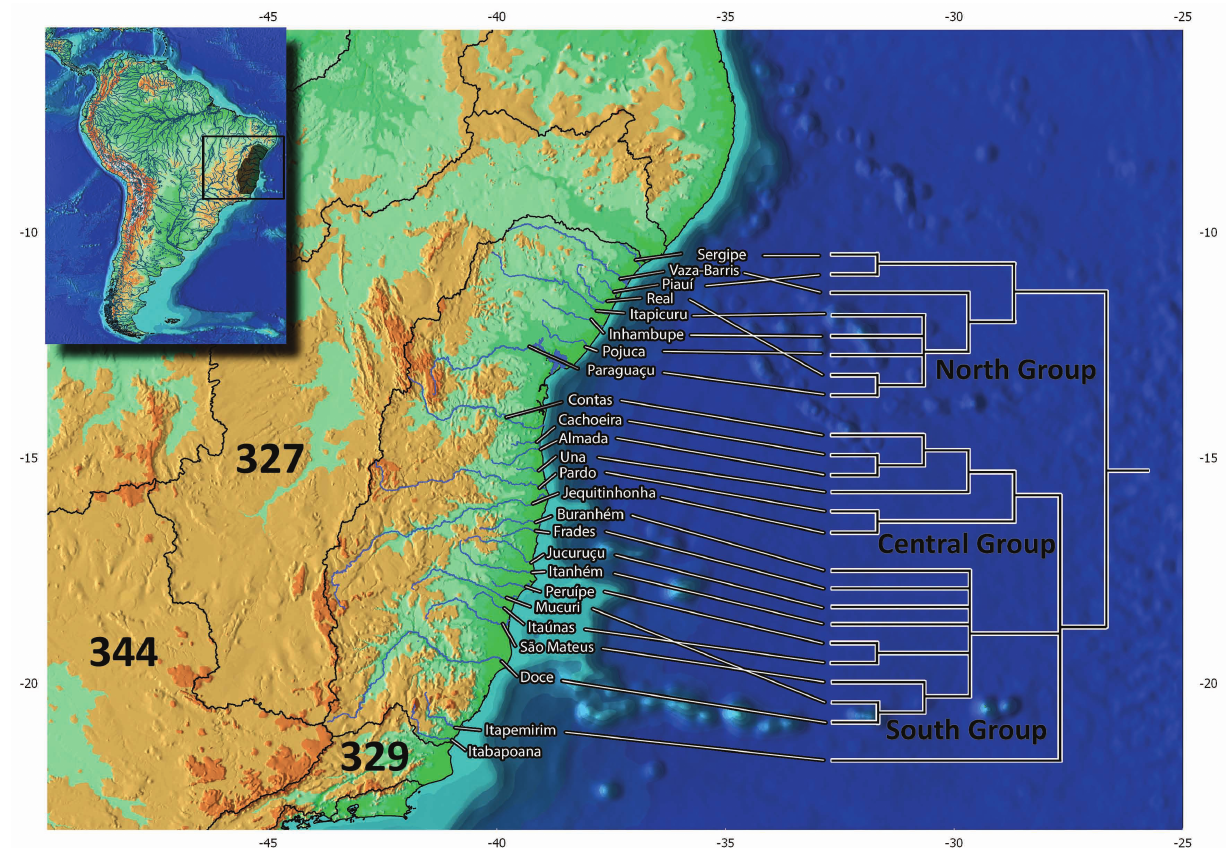
Fig. 1. Map showing the Northeastern Mata Atlântica ecoregion, the rivers included in the PAE, and the groups recovered from the analysis. Adjacent freshwater ecoregions are: (327) São Francisco, (329) Paraíba do Sul, and (344) Upper